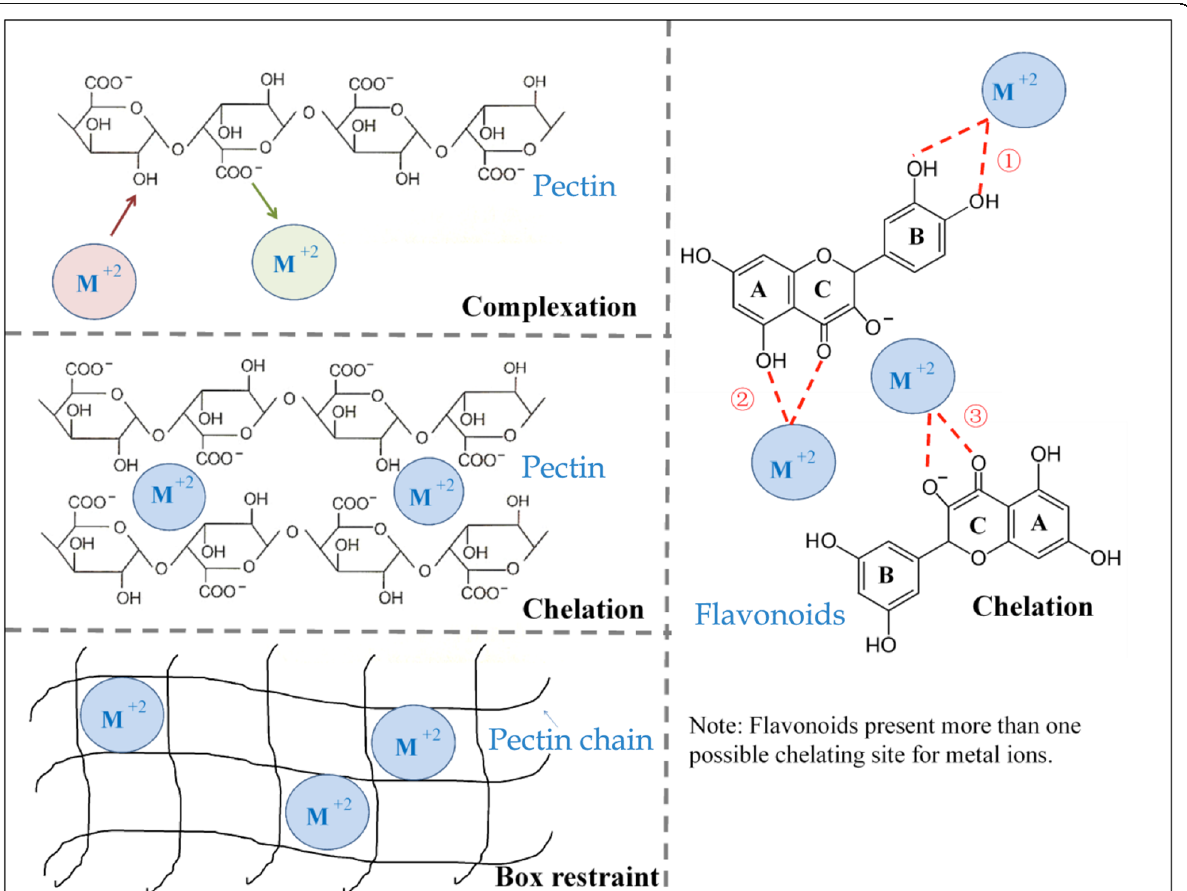
Fig. 2 Interaction natural between bioactive substances and heavy